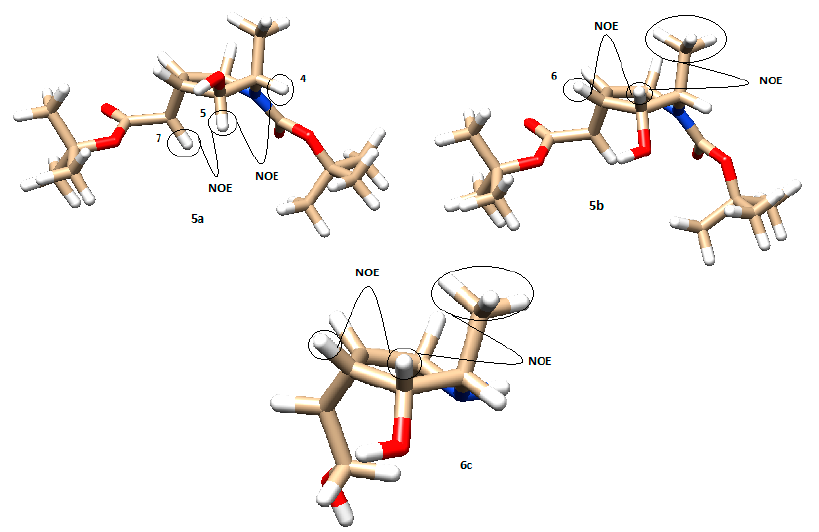
Figure 5. Model of compounds 5a, 5b , and 6c with their main NOE interactions (brown: carbon; white: hydrogen; red: oxygen; blue: nitrogen).